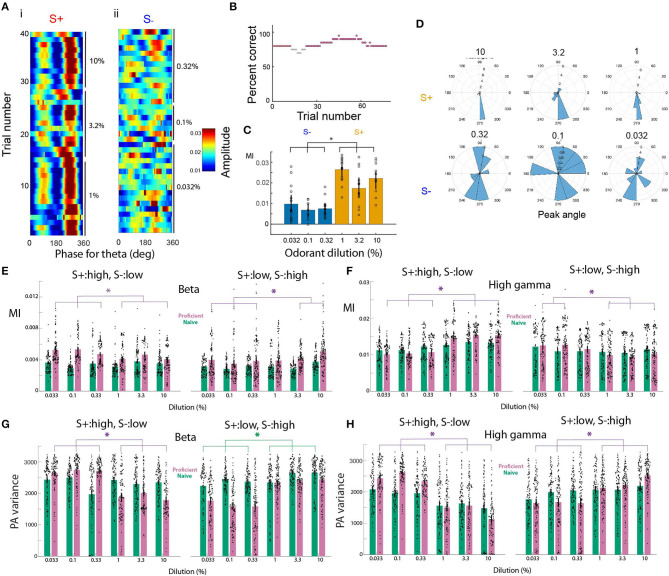
Phase amplitude coupling for the go-no go odorant concentration task. (A–D) tPAC analysis shown for a go-no go session where the mouse was proficient in differentiating between the high concentration odorants (cliq 1–10%, rewarded stimulus, S+) and the low concentration odorants (cliq 0.033–0.33%, unrewarded stimulus, S-). (A) Pseudocolor image showing the per-trial average amplitude for the theta envelope for the gamma LFP. The odorant used was isoamyl acetate. Odorant dilutions (cliq) for S+ were 10, 3.33, and 1% and for S- were 0.33, 0.1, and 0.033%. (B) Percent correct as a function of trial number. Light gray: percent correct >65% and <80%, magenta: percent correct ≥80%. (C). Strength of tPAC quantified as the modulation index (MI) displayed for the six odorant dilutions. A GLM analysis indicated that there is a difference between S+ and S- (p < 0.001, 77 trials, 71 d.f., F-Statistic 18.3, p-value for the model < 0.001). The asterisk denotes post-hoc differences evaluated with either t-test or ranksum, p < pFDR = 0.033. (D) Rose plot histograms for the peak phase angle for gamma tPAC shown in (A). (E,F) Modulation index quantifying the strength of tPAC. The bars show the average MI per electrode for all mice (n = 16 electrodes and nine mice). The violin plot shows the MI per electrode for each mouse. Green bars are the MI for naïve mice (percent correct ≤ 65%) and magenta bars are the MI for proficient mice (>80%). E. MI for beta, F. MI for gamma. For the beta tPAC a GLM finds statistically significant differences between odorant concentrations and between naïve and proficient, but not between naïve and proficient and for the interaction between naïve vs. proficient and concentration (p < 0.001, 2,784 observations, 2,776 d.f., F-statistic = 61.2, p < 0.001, nine mice). For the gamma tPAC a GLM finds statistically significant differences between odorant concentrations, between naïve and proficient and between naïve and proficient (p < 0.001, 2,784 observations, 2,776 d.f., F-statistic = 47.5, p < 0.001, nine mice). (G,H) Variance of the peak angle for tPAC. The bars show the average peak angle variance per electrode for all mice (n = 16 electrodes and nine mice). The violin plot shows the peak angle variance per electrode for each mouse. Green bars are for naïve mice (percent correct ≤ 65%) and magenta bars are for proficient mice (>80%). (G) beta, (H) gamma. For the beta tPAC a GLM finds statistically significant differences between odorant concentrations, between naïve and proficient and between naïve and proficient (p < 0.001, 2,784 observations, 2,776 d.f., F-statistic = 100, p < 0.001, nine mice). For the gamma tPAC a GLM finds statistically significant differences between odorant concentrations, between naïve and proficient and between naïve and proficient (p < 0.001, 2,784 observations, 2,776 d.f., F-statistic = 99.2, p < 0.001, nine mice).